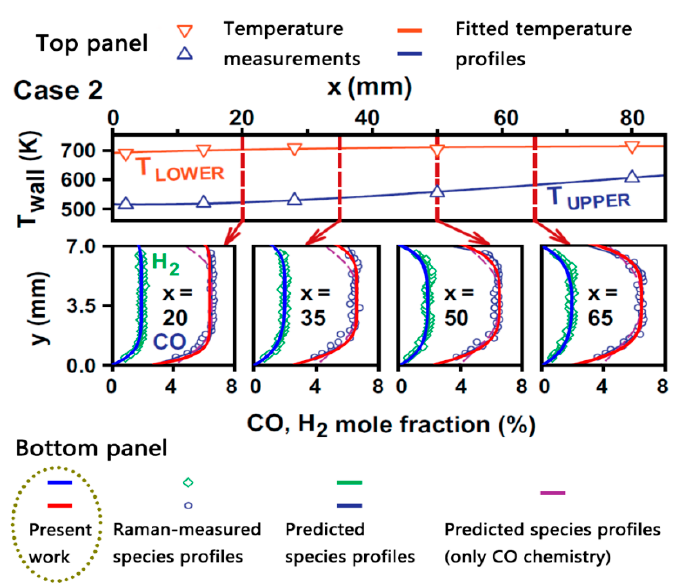
Figure 5. Transverse profiles of carbon monoxide and hydrogen mole fractions at the streamwise positions indicated, compared to the experimental data and numerical results reported in the literature [10]. The top panel shows the temperature measurements and the fitted temperature profiles. The bottom panel shows the numerical predictions of the present work, as well as the experimental data and numerical results reported in the literature [10].